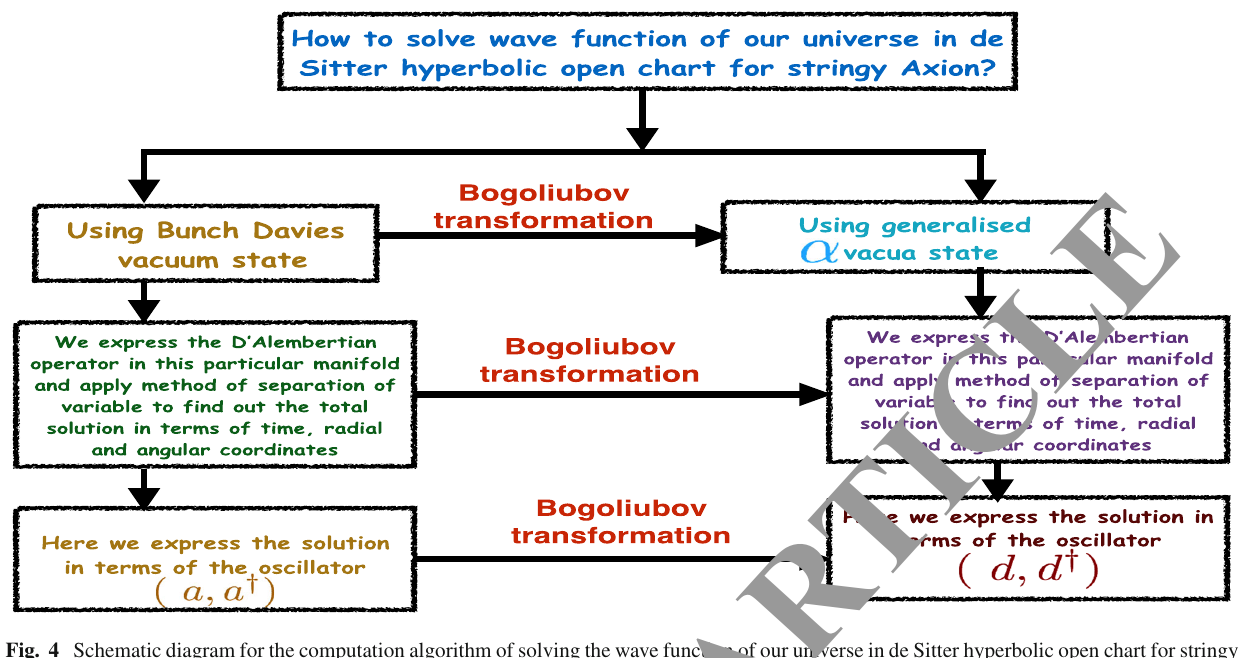
Fig. 4 Schematic diagram for the computation algorithm of solving the wave function of our universe in de Sitter hyperbolic open chart for stringy